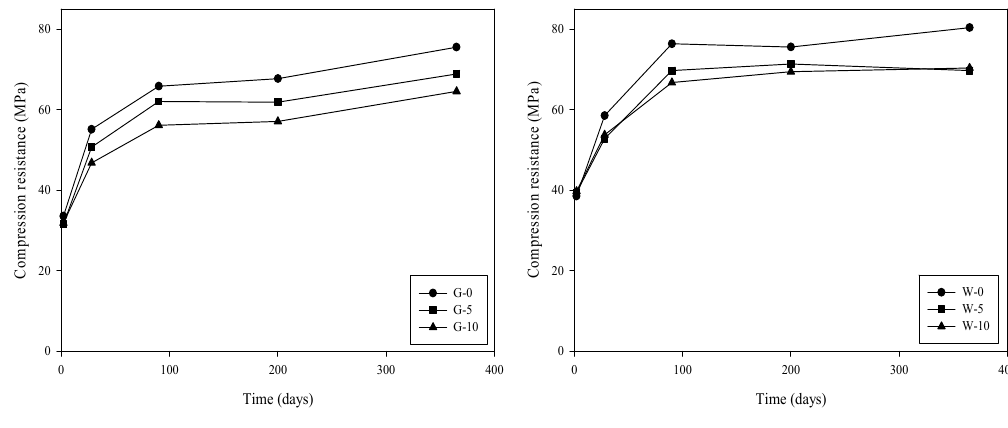
Figure 1. Compression strength. ( a ) G-samples ( b ) W-samples.